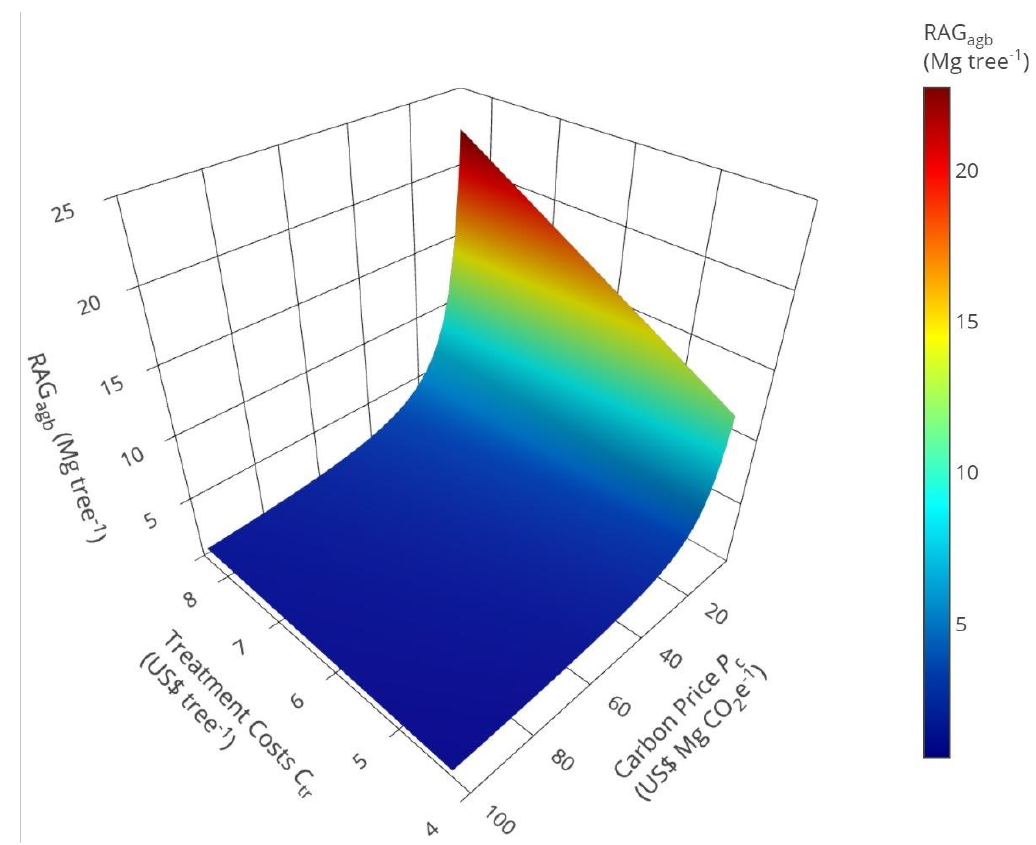
Figure 3. Required additional above ground biomass growth per tree (response–surface) after 130 years (recovery time). RAG agb = required additional AGB growth per FCT, treatment costs C tr = treatment costs per FCT, carbon price P c = carbon price per Mg CO 2 e -1 .